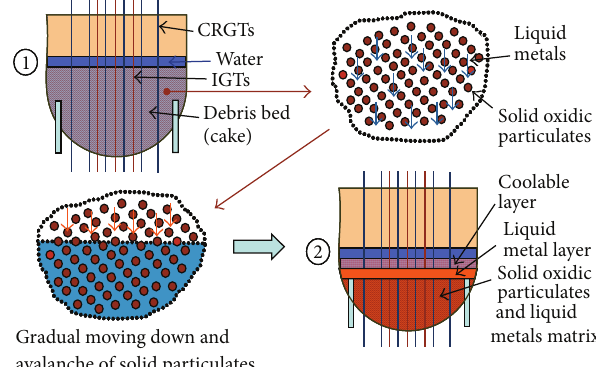
Figure 16: A severe accident scenario in the BWR lower head.